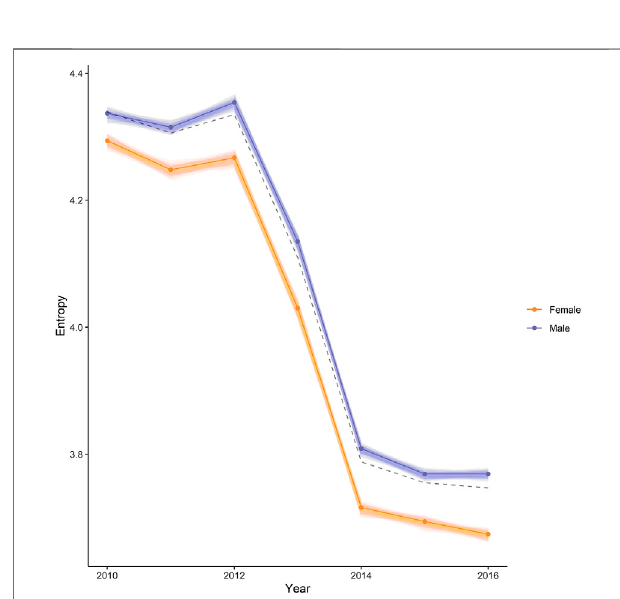
FIGURE 7 | Entropy by Sex Across Years. Results show that entropy was higher for the male sub-population (purple) than the female sub- population (orange), while the baseline entropy of the population taken as a whole (dotted black) falls in between. This indicates that enrolments for female students were more ordered, and male enrolments were more